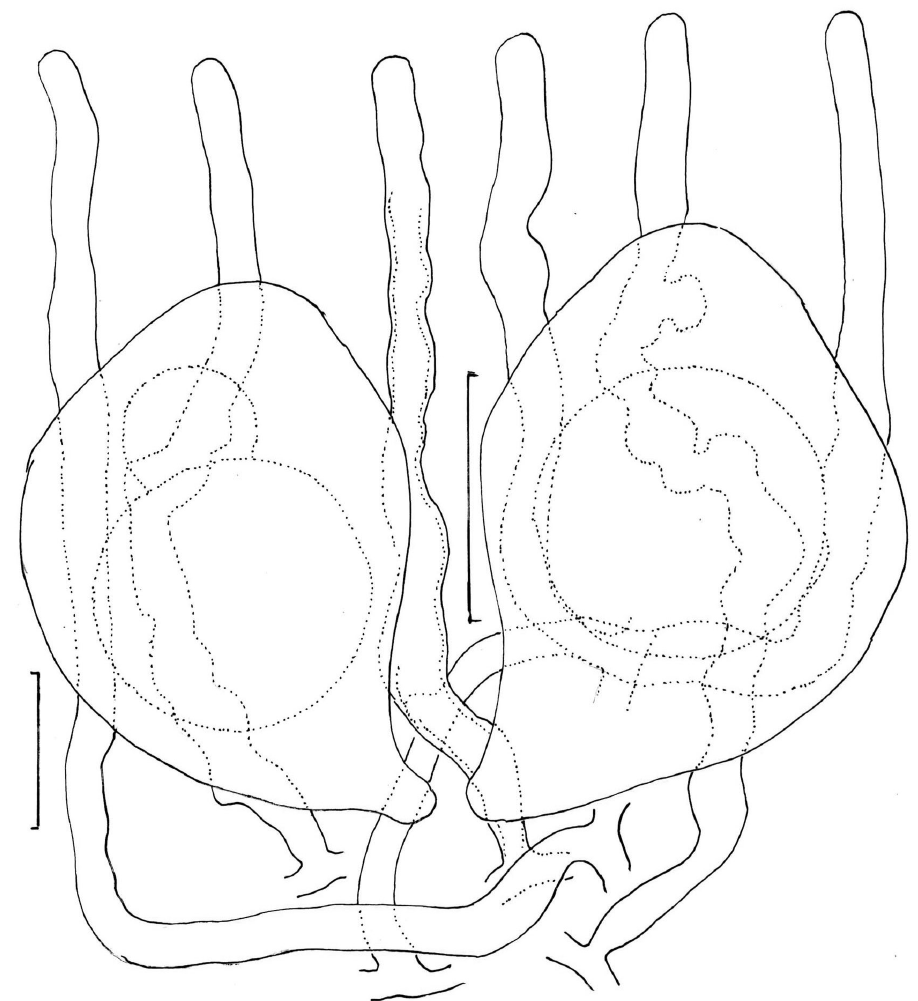
Figure 40. Mycetinis kallioneus . A Caulocystidia from lower stipe surface B Basidiospores. Standard bars: A = 20 µm; B = 5 µm. TB 85-209